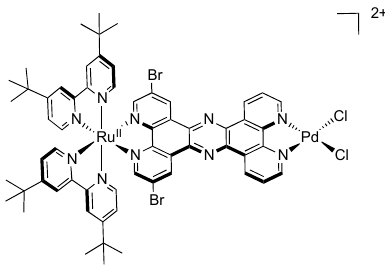
Figure 49. [Ru(tbbpy) (TPPHZ)] 2+ bearing a bromine substituted 2